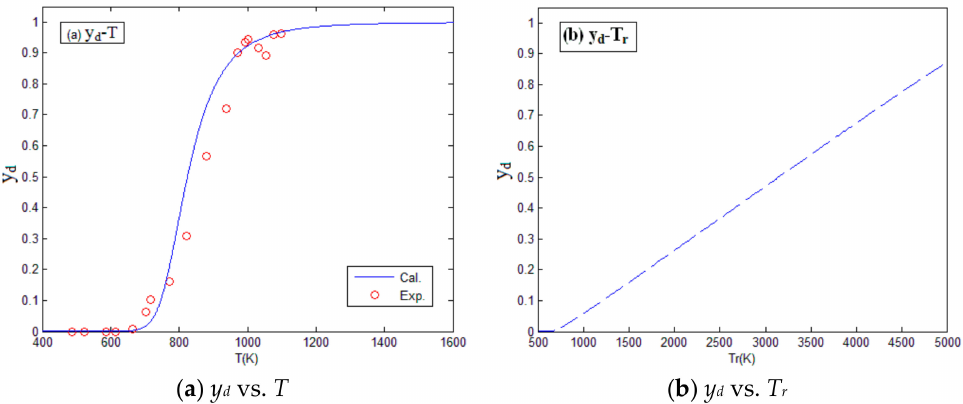
Figure 9. The relation between reaction degree and impact temperature. ( a ) The relation between the degree of reaction and temperature before material reaction; ( b ) The relation between the degree of reaction and temperature after material